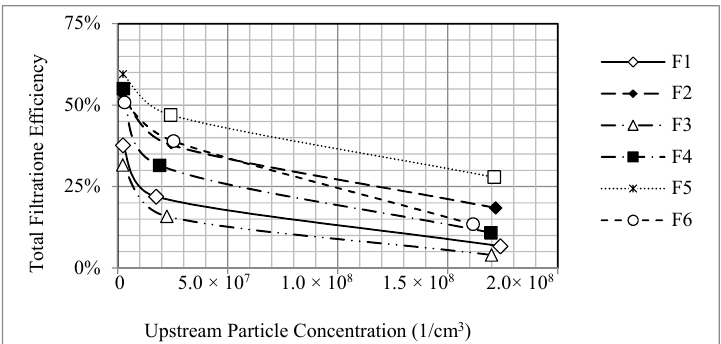
Figure 7. Total filtration efficiencies of electrospun filters as a function of upstream particle concentration.